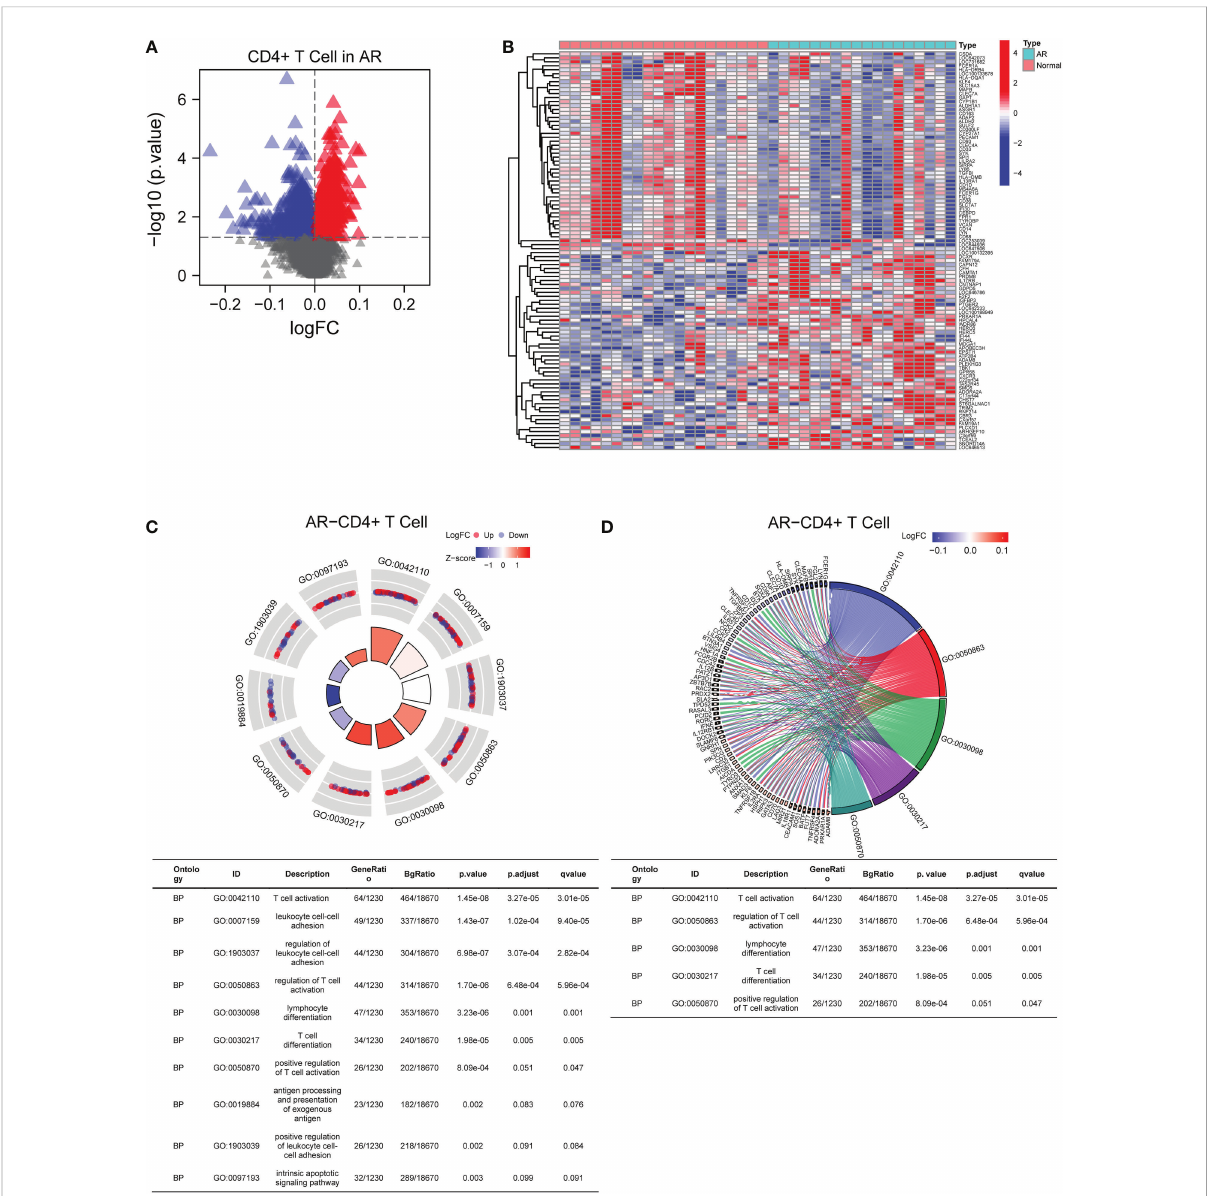
FIGURE 2 Identi fi cation and functional enrichment analysis of DEGs in AR-related CD4+T cells. (A) The volcano plot screened DEGs in CD4+T cells from AR patients. (B) The heat map displayed the top 100 DEGs with correlation. (C) GO pathway enrichment analysis data for DEGs (the top 10 were shown in the circle plot). (D) GO chord plot of DEGs (the top 5 were shown). AR, allergic rhinitis; GO, Gene